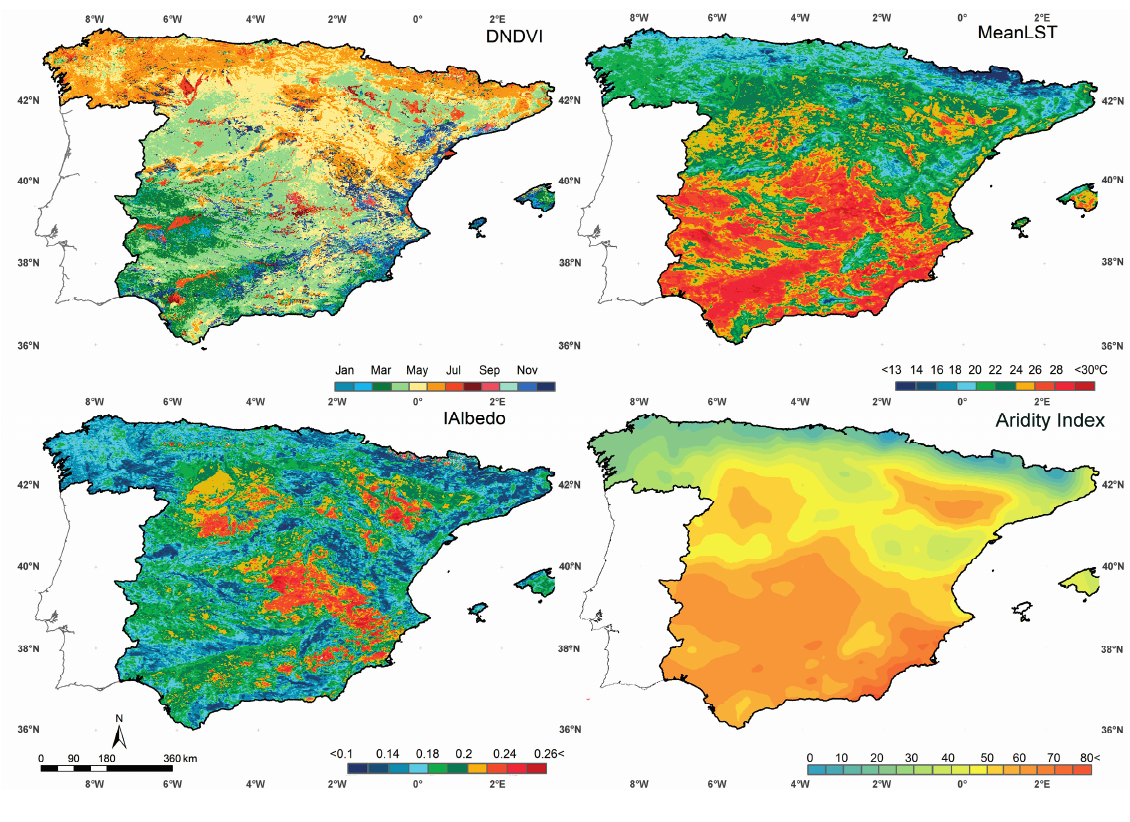
Figure 4. Example of several functional variables (Date of maximum Normalized Difference Vegetation Index (DNDVI), Normalized Difference Vegetation Index (NDVI), Mean Land Surface Temperature (MeanLST), IAlbedo, Aridity